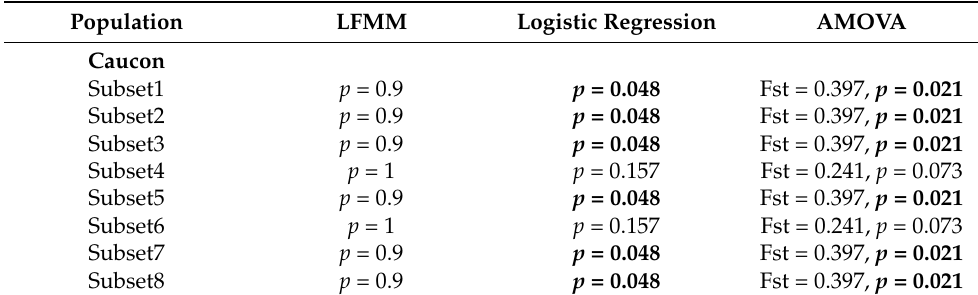
Table 2. Iteratively gene–phenotype AMOVA analysis results in randomly selected mature and low individuals (4 alive individuals vs. the 4 dead individuals in Saucillo, and 5 alive individuals vs. the 5 dead individuals in Caucon). Significant results are highlighted in